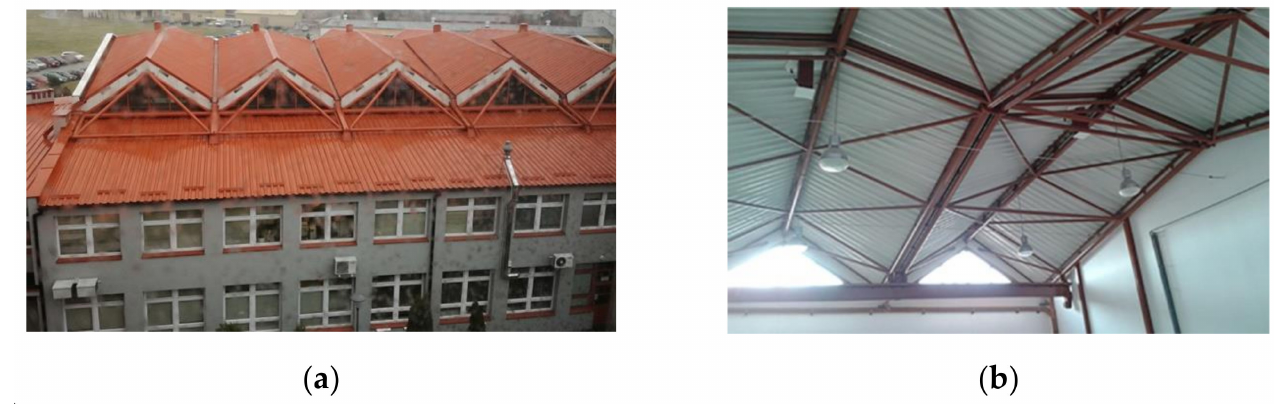
Figure 2. Complex shell structure roofing an experimental hall: ( a ) an outside view; ( b ) an inside view.